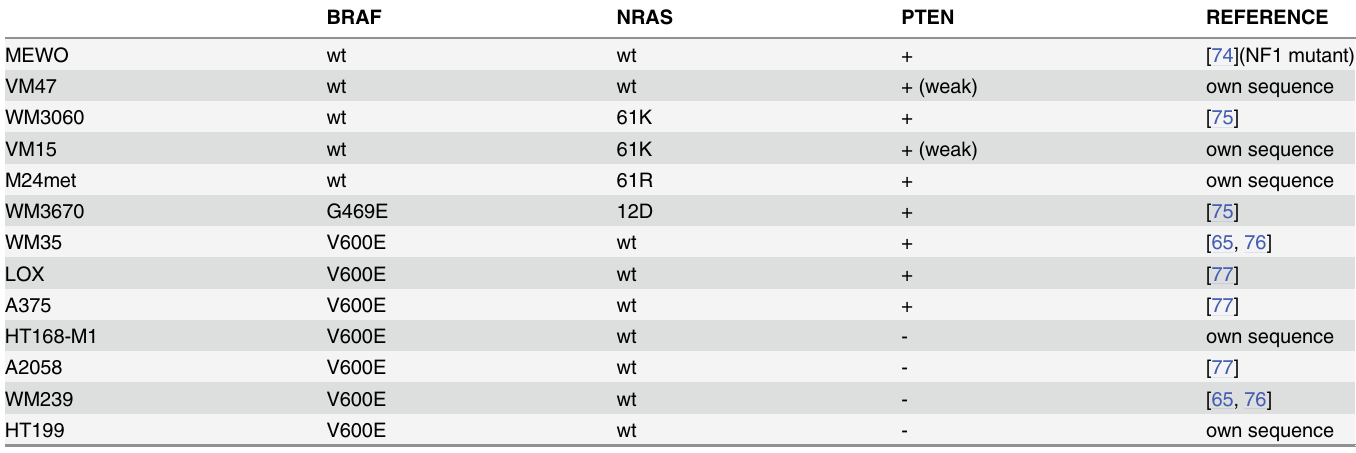
Table 1. Mutational status of all 13 human melanoma cell lines. BRAF NRAS PTEN